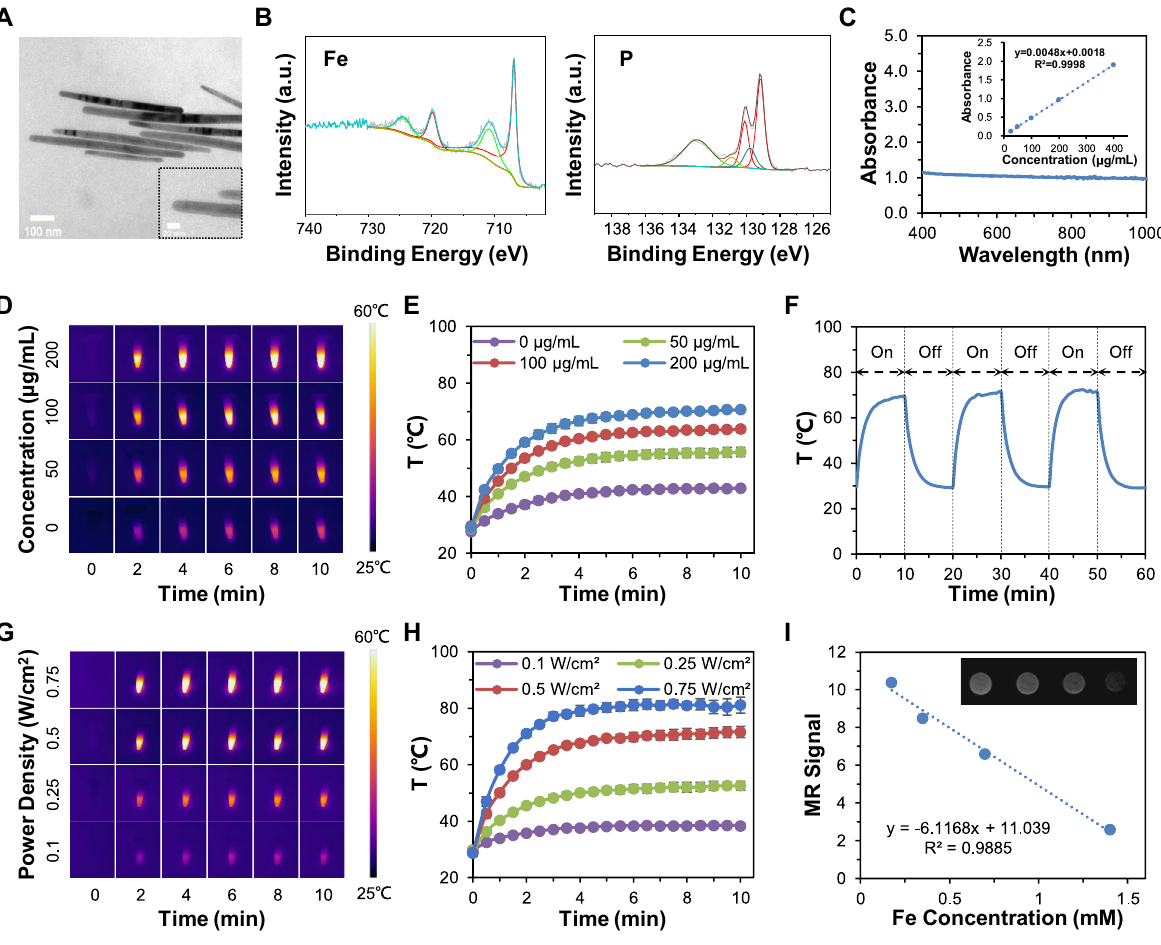
Figure 1: Characterization of Fe2P-PEG-Mal